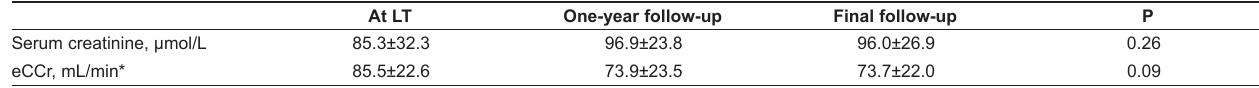
Table 2 Renal function parameters at liver transplantation (lT), one-year post-lT and final follow-up